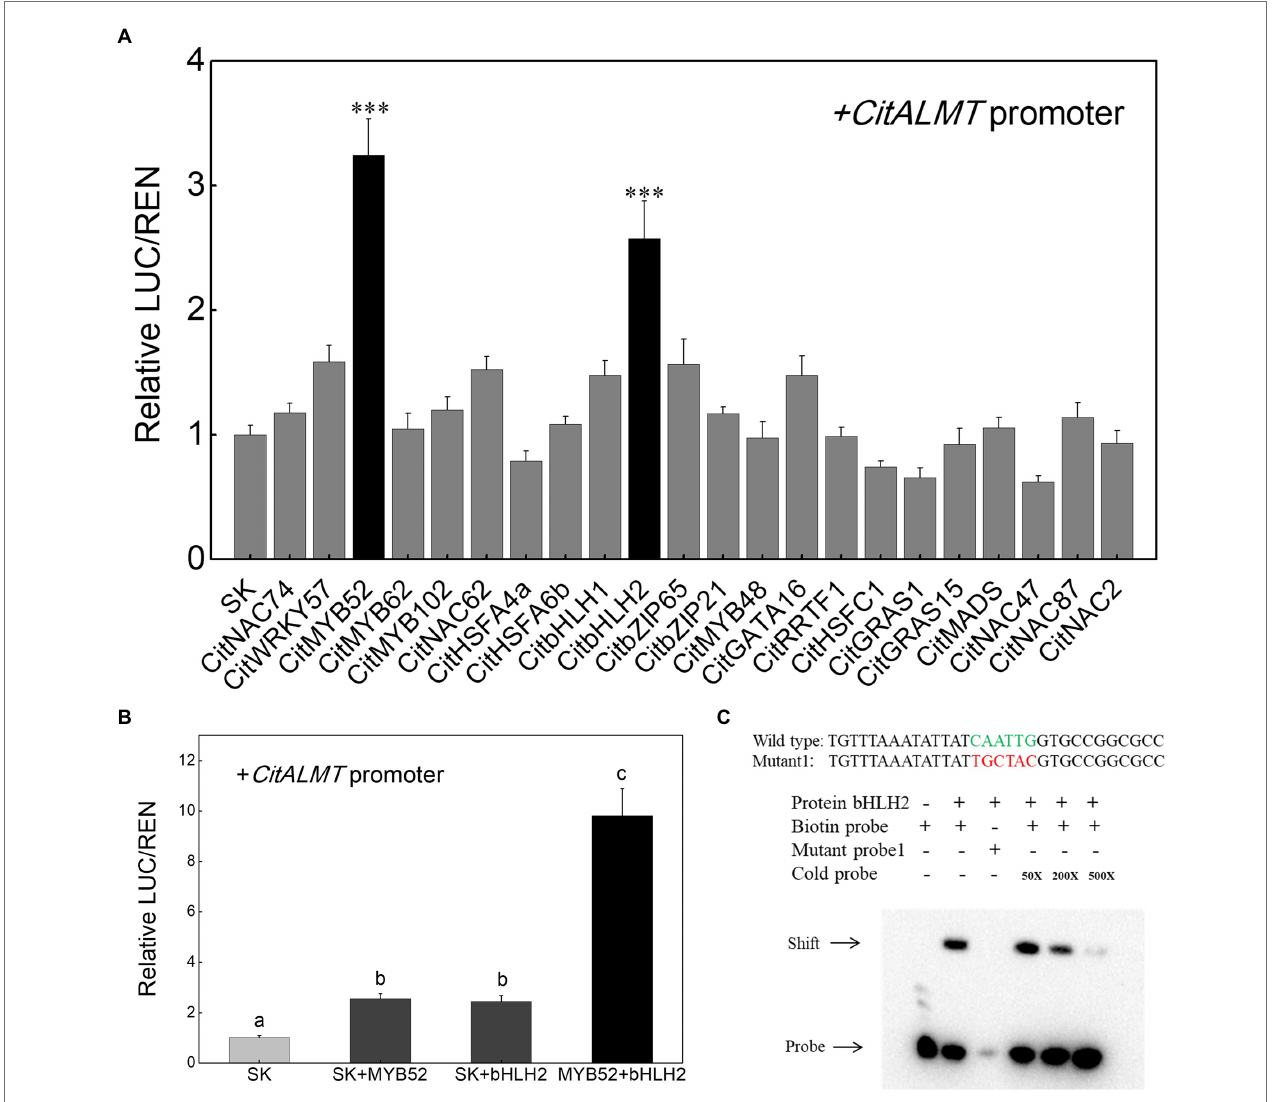
FIGURE 3 | Interaction between transcription factors and CitALMT ’s promoter. (A) In vivo interaction of transcription factors with the promoter of the CitALMT gene from “Ponkan” fruit. In vivo associations of the transcription factors and promoter were obtained by transient expression assays in tobacco leaves. The ratio of LUC/ REN of the empty vector (SK) plus promoter was used as calibrator (set as 1). Error bars indicate SE from at least five replicates. *** Significant differences ( p < 0.001). (B) Effect of the combination of CitMYB52 and CitbHLH2 on the CitALMT ’ promoter. The ratio of LUC/REN of the empty vector (SK) plus promoter was used as calibrator (set as 1). Error bars indicate SEs from five biological replicates. Different letters above the columns represent significant differences (the combination effects were compared to two individual effects, p < 0.05). (C) Electrophoretic mobility shift assay (EMSA) of CitbHLH2 binding to the CitALMT promoter. Purified CitbHLH2 proteins and biotin-labeled DNA probe were mixed and analyzed on 6% native polyacrylamide gels. The presence (+) or absence ( − ) of specific probes is indicated. The concentration of the cold probe is shown; the biotinylated probe concentration was 1